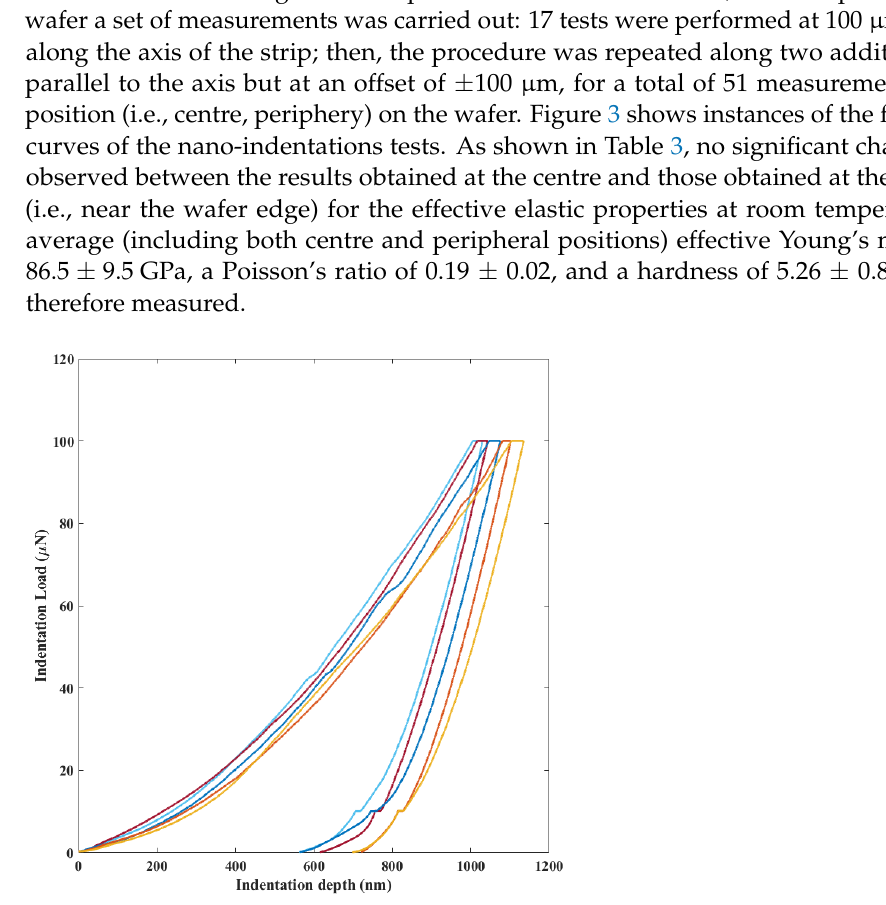
Figure 3. Exemplary indentation load-depth curves to obtain the elastic mechanical properties of the gf film. Table 3. Effective elastic properties and hardness for the gf material, as obtained from nanoindentation tests at room